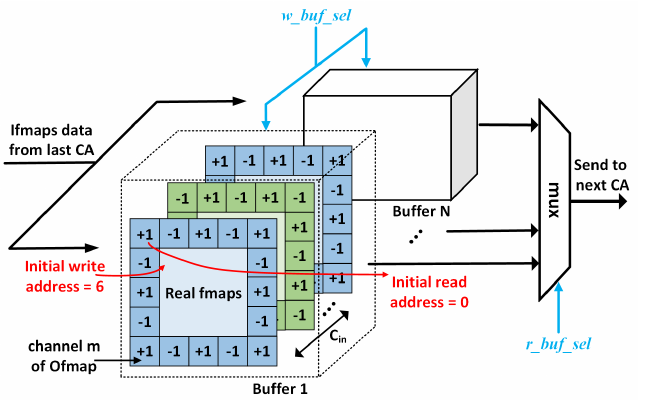
Figure 8. The structure of feature map buffer. The w _ buf _ sel and r _ buf _ sel signals are the choice signals for the write buffer and the read buffer,